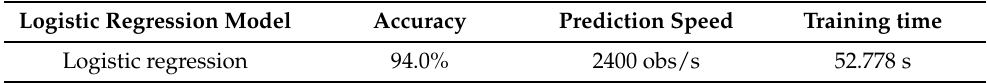
Table 6. Accuracy of Logistic Regression